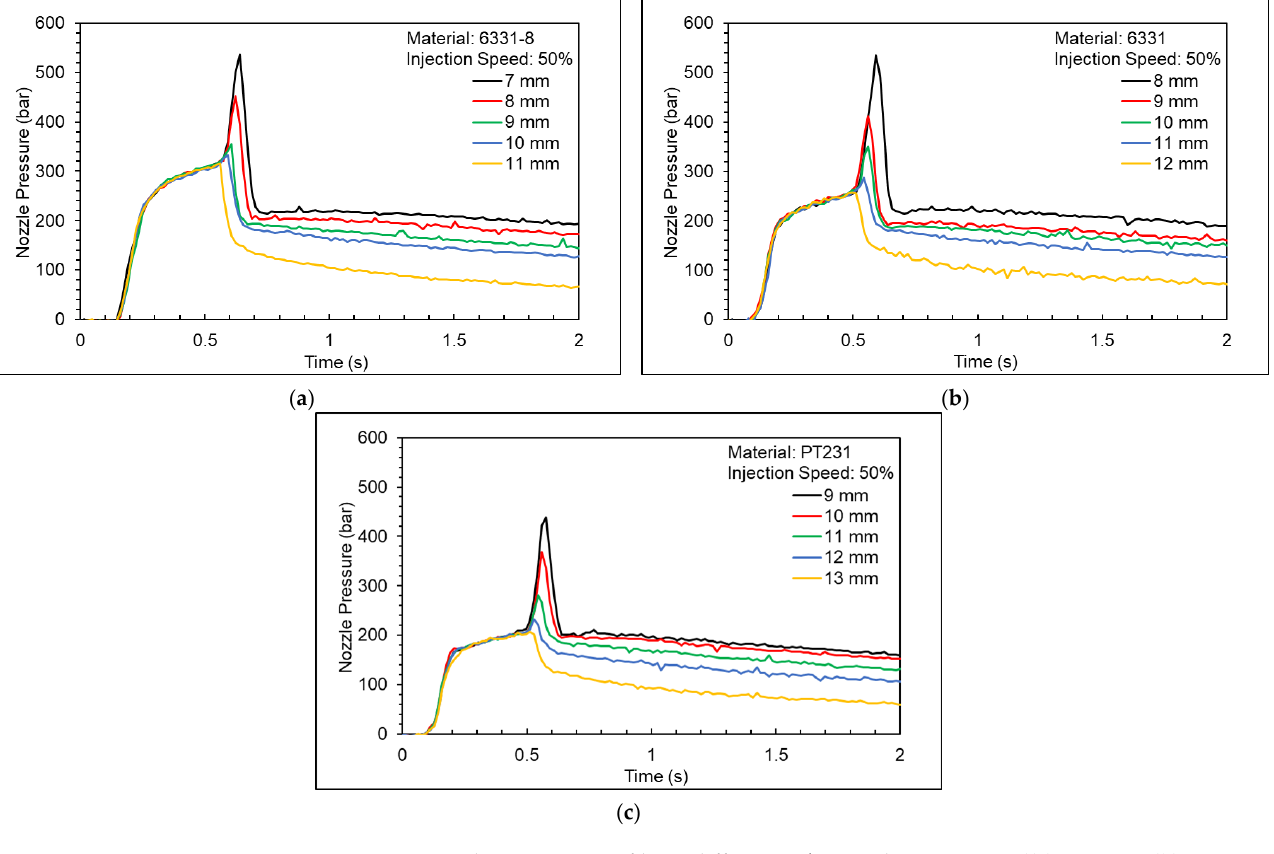
Figure 11. Nozzle pressure profile at different V/P switchover points (( a ) 6331 − 8, ( b ) 6331, and ( c ) PT231).